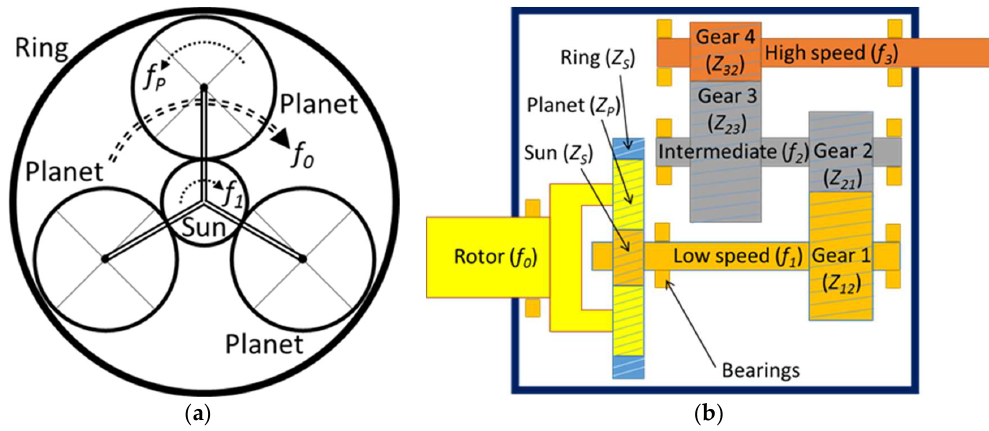
Figure 2. ( a ) Front view of the planetary gear; ( b ) Lateral view of the entire gearbox. Table 1. Nomenclature adopted to identify the angular rotation frequencies of the drive train shafts. Rotor Planet Low Speed